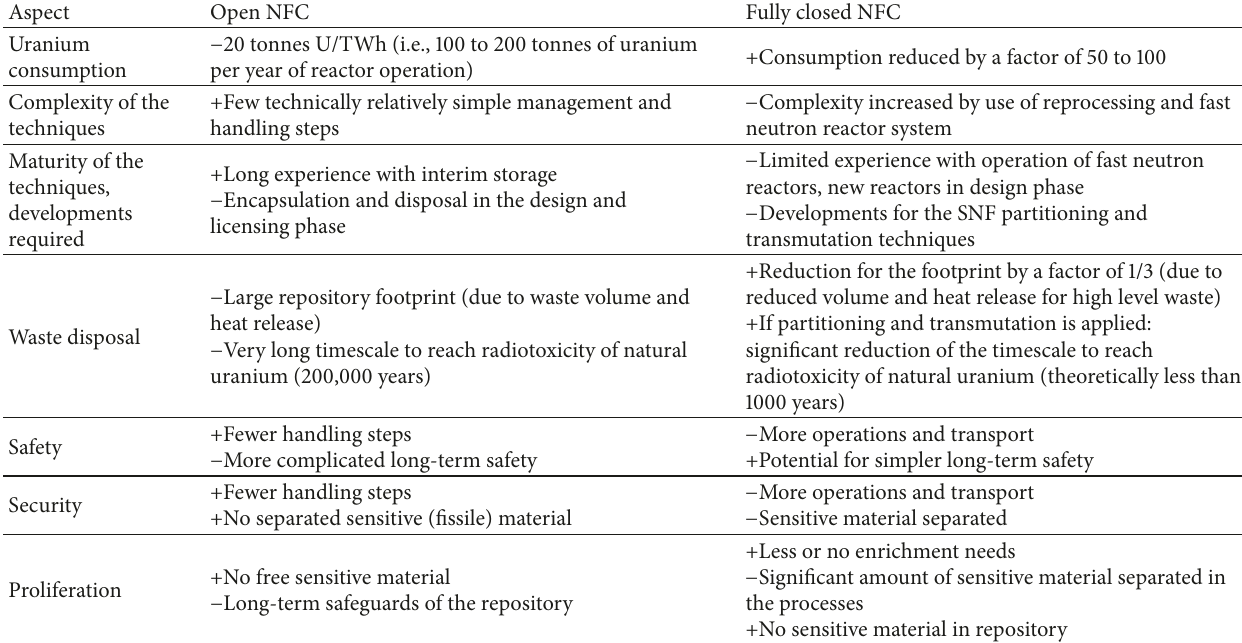
Table 2: Challenges and opportunities associated with the open and the closed NFC and nuclear waste management options [7].